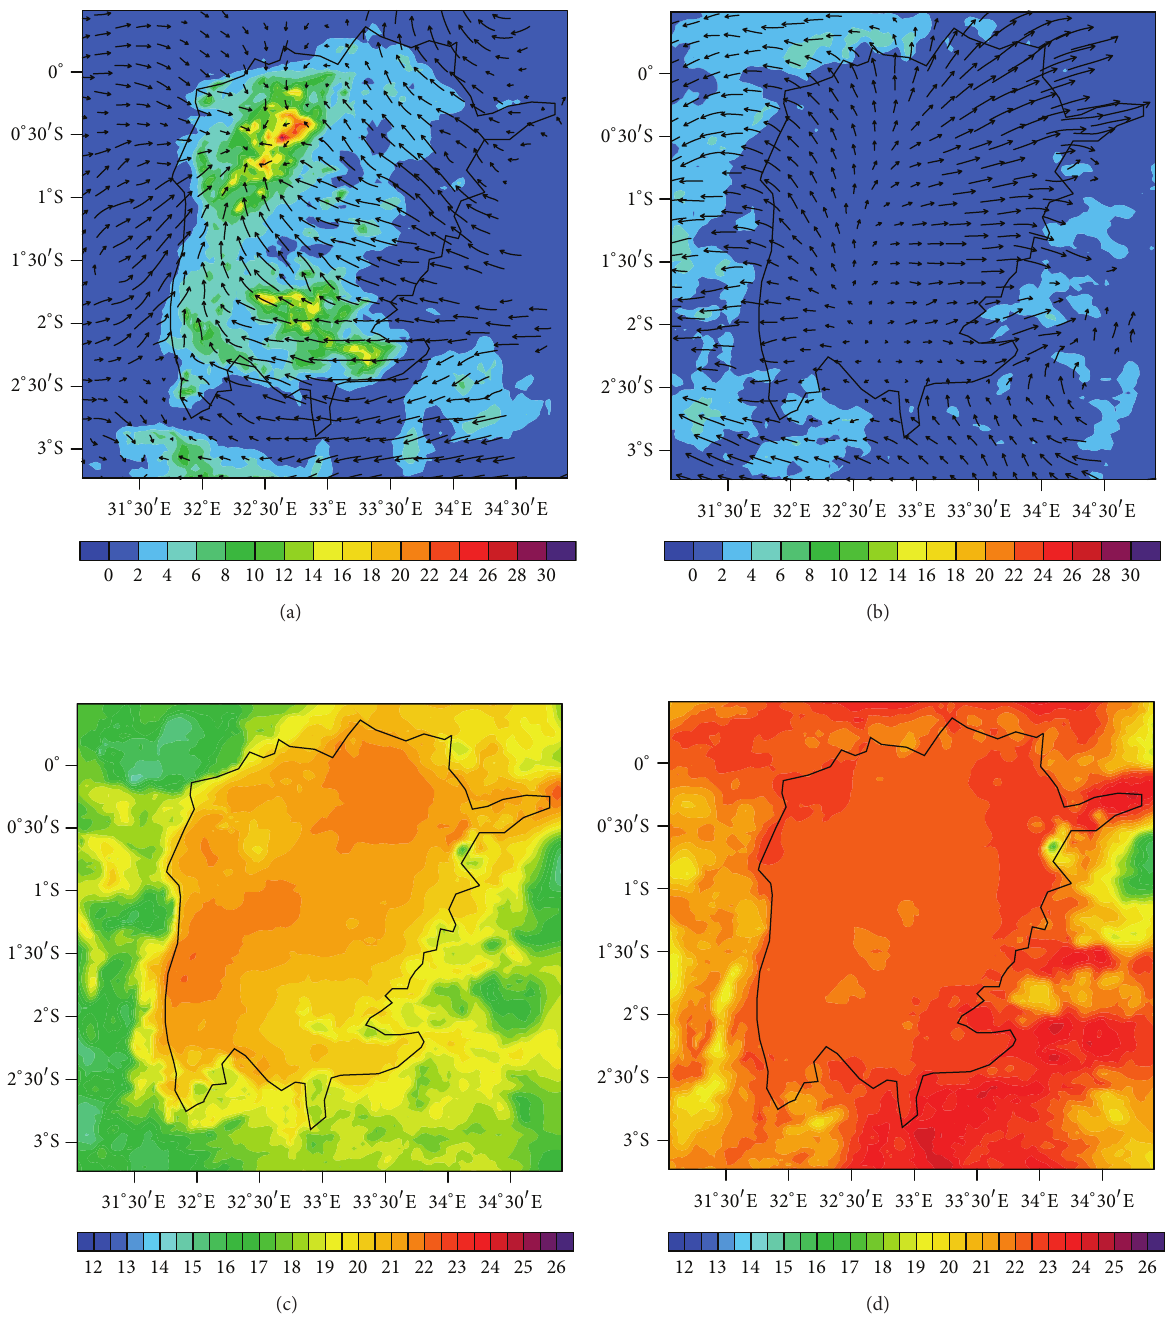
Figure 10: The 850 hPa mean flow (arrows) overlaid on precipitation (a, b) and the 2 m air temperature (c, d) over the LVB at 0600 LST (a, c) and 1500 LST (b,